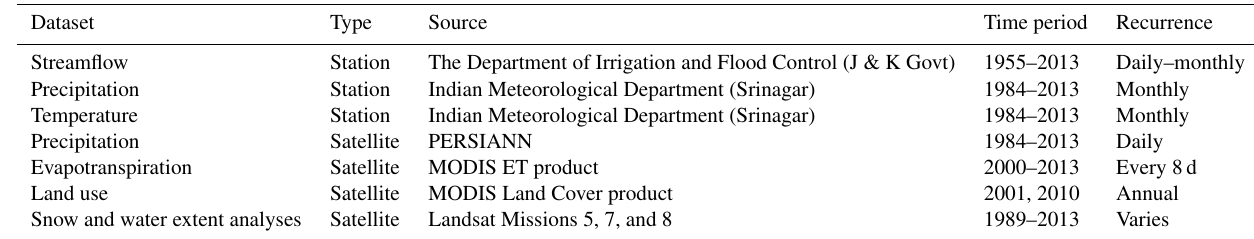
Table 1. Datasets used in analyses. Note: Government of Jammu and Kashmir is abbreviated to J & K Govt.